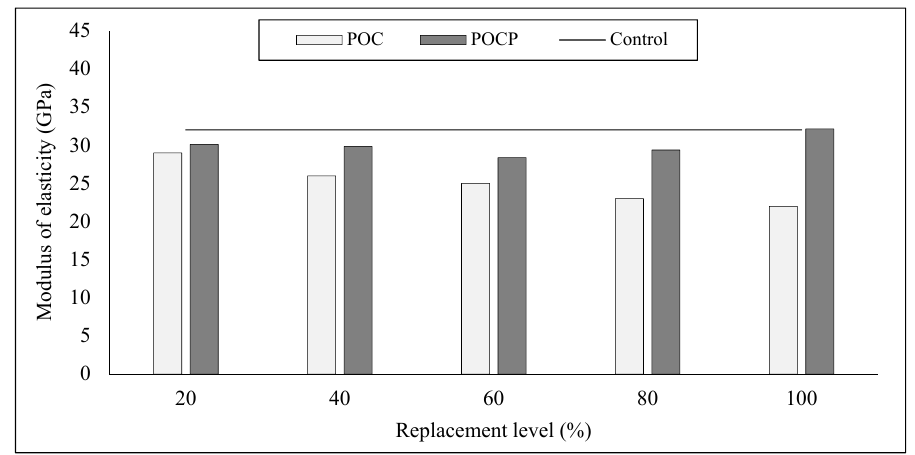
Figure 23. 28-day modulus of elasticity of POC and POCP concretes.